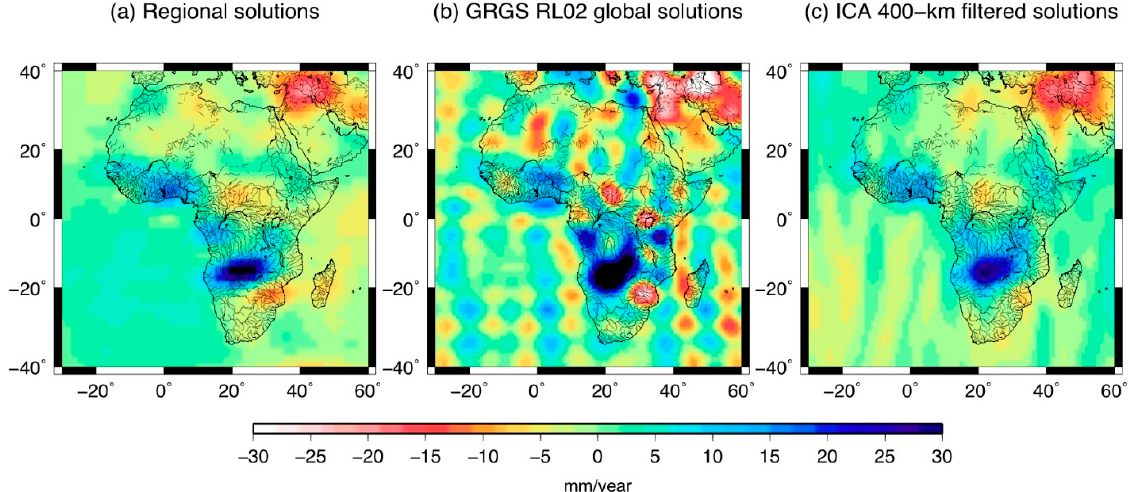
Figure 7. Comparison of maps of water mass linear trends computed using different GRACE-related products: ( a ) regional 2° × 2° mascon-like solutions, ( b ) Centre National d’Etudes Spatiales/Groupe de Recherche en Géodésie Spatiale (CNES/GRGS) Spherical Harmonics (SH) solutions revealing important unrealistic North-South striping and ( c ) linear combination of SH solutions through Independent Component Analysis (ICA). Source: